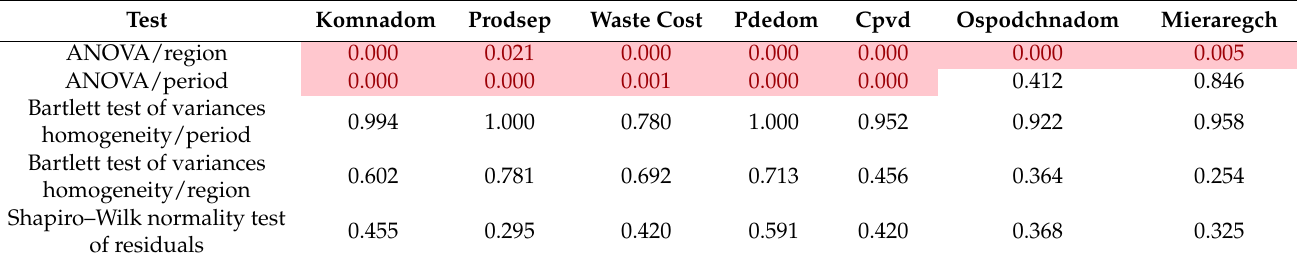
Table 4. Results, p values of ANOVA test and verification of assumptions